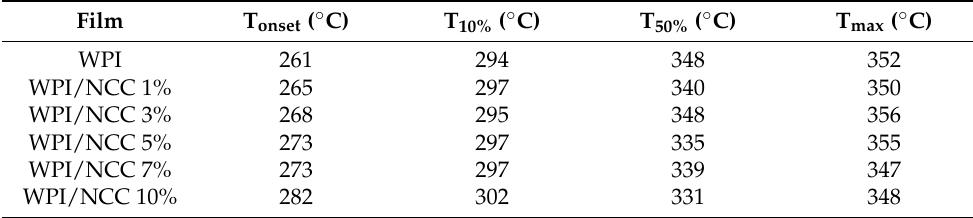
WPI: whey protein isolate, NCC: nanocrystalline